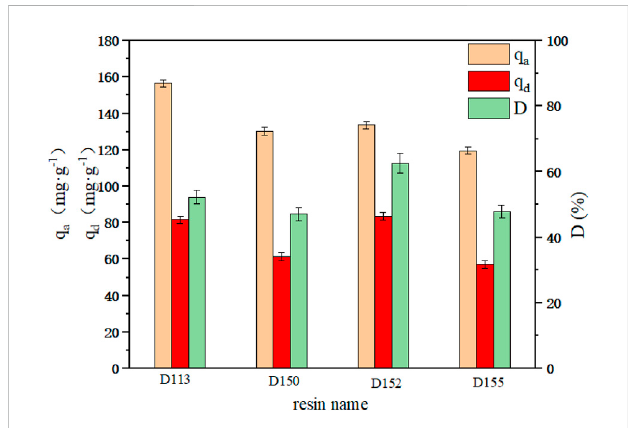
FIGURE 1 Adsorption and desorption capacity of different cation exchange resins.